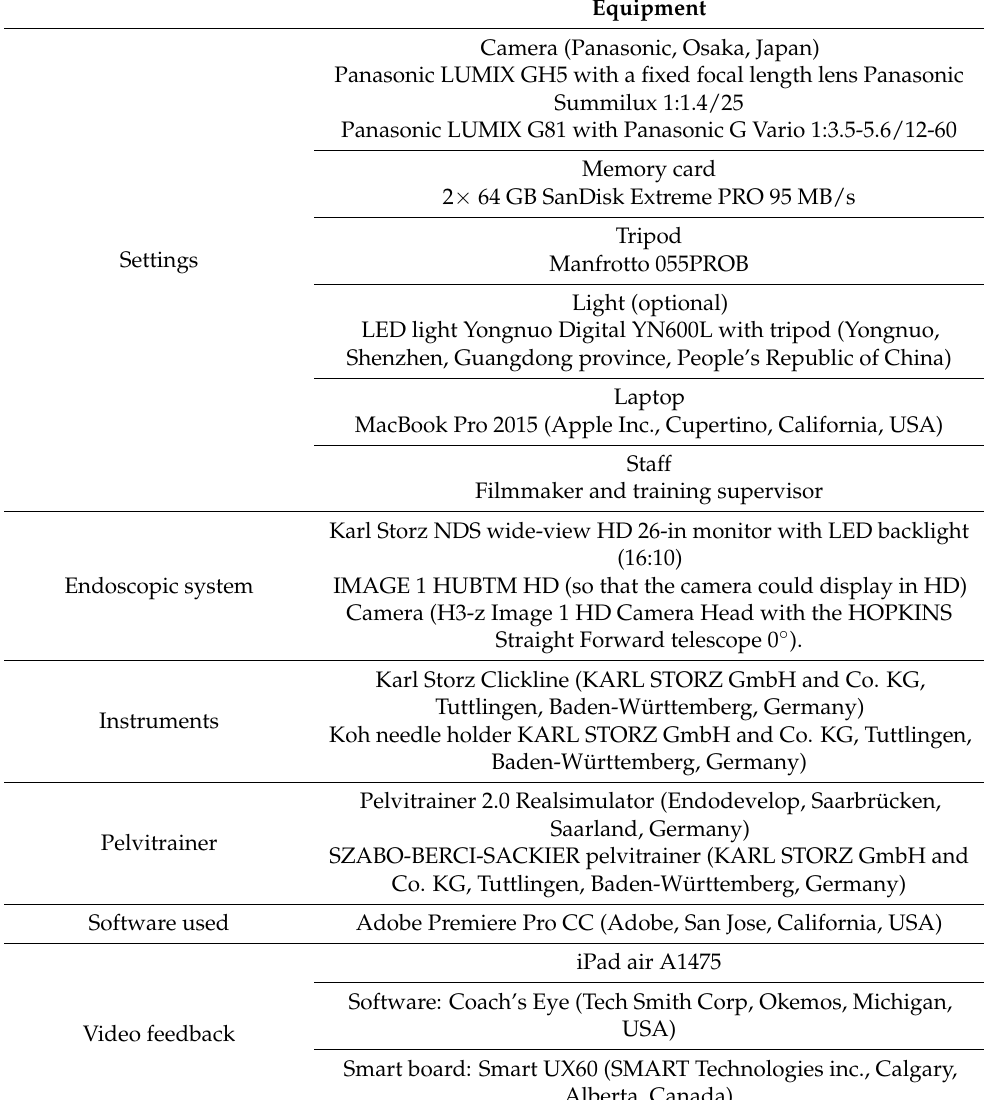
Table 1. List of equipment